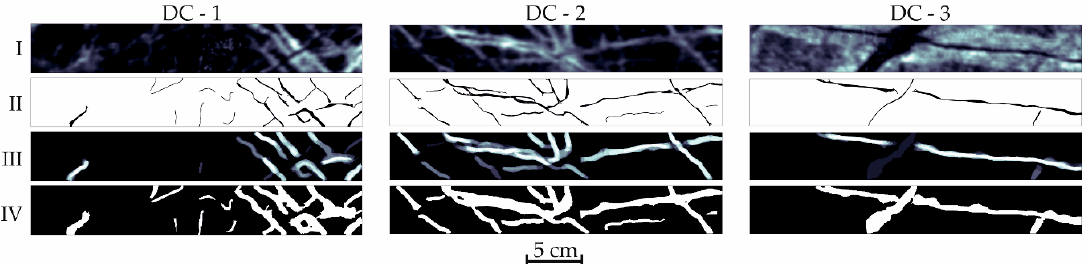
Figure A2. Results of the vein extraction performed on binary images resulting from a band math calculation representative of the abundance of white mica: 2170/2206. I = endmember abundance map, II = extracted ridges for sigma ranging from 3 to 10 and thresholds ranging from 98% to 92%, III = overlapping polygons after connecting extracted lines to their respective edges (features detected with wider range of sigma are brighter), IV = extracted veins after merging all polygons.